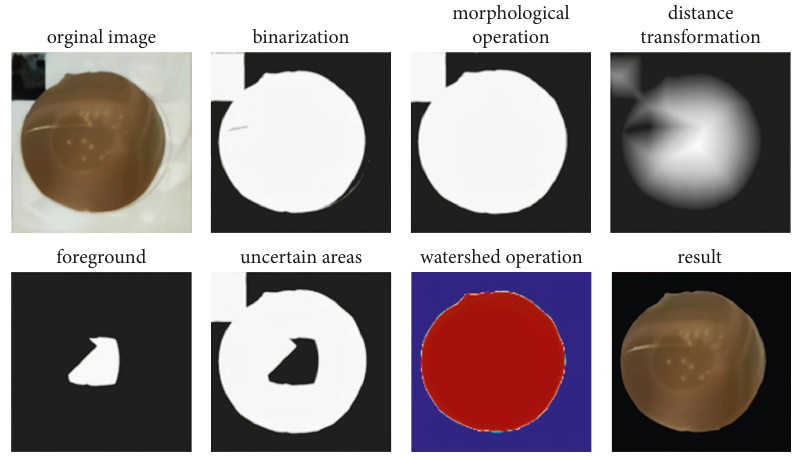
Figure 4: The segmentation results of the watershed algorithm.